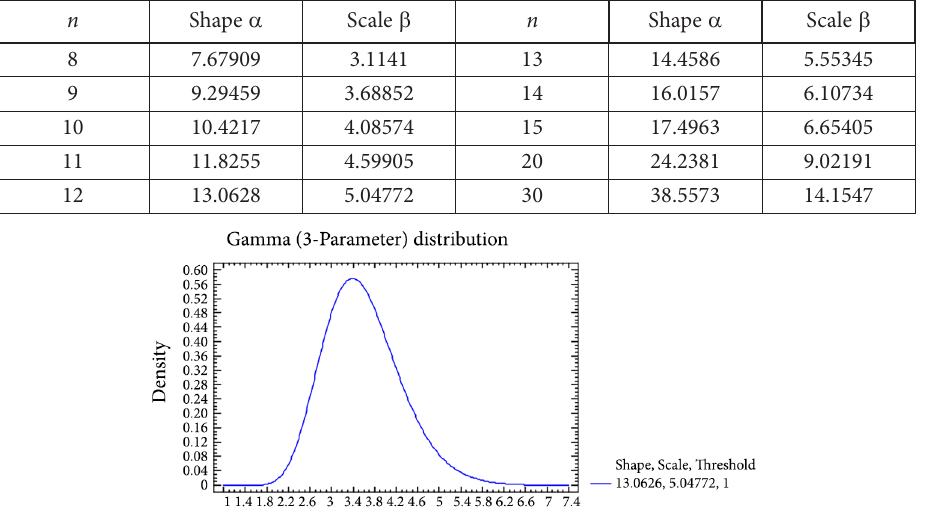
Table 4. Gamma distribution parameters () of the sample geometric dispersion n Shape α